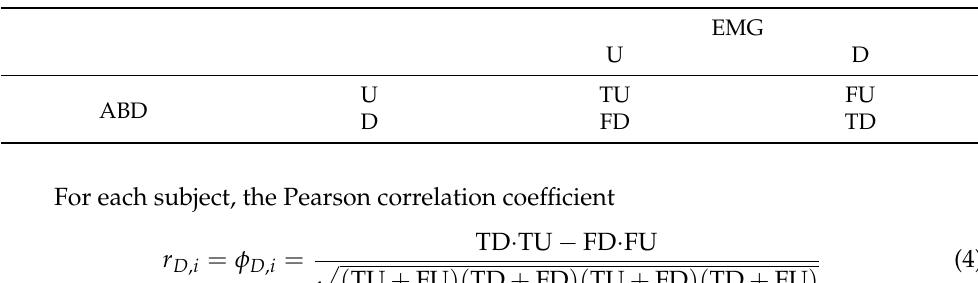
Table 1. Contingency table used for the analysis of event detection correlation between ABD and EMG, assuming the latter as the ground truth. U = undetected, D = detected, TU = true undetected FU = false undetected, FD = false detected, TD = true detected.